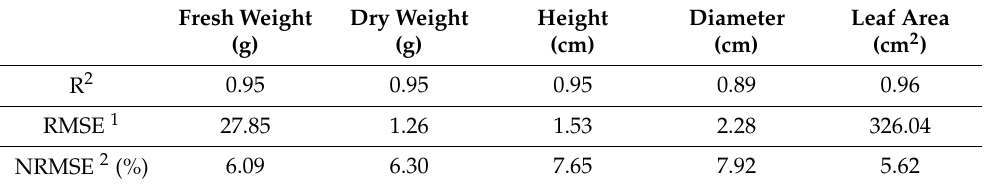
Table 3. Growth index estimation of the developed two-stage CNN model using RGB-D